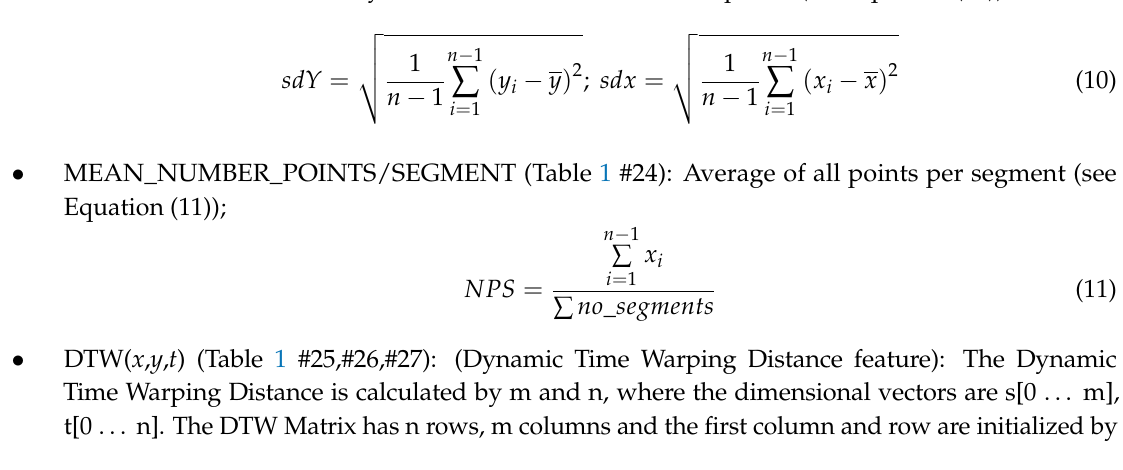
Figure 7. Representation of the parameter “REGANGLE” . Figure 8. Width and Height of character sequence.